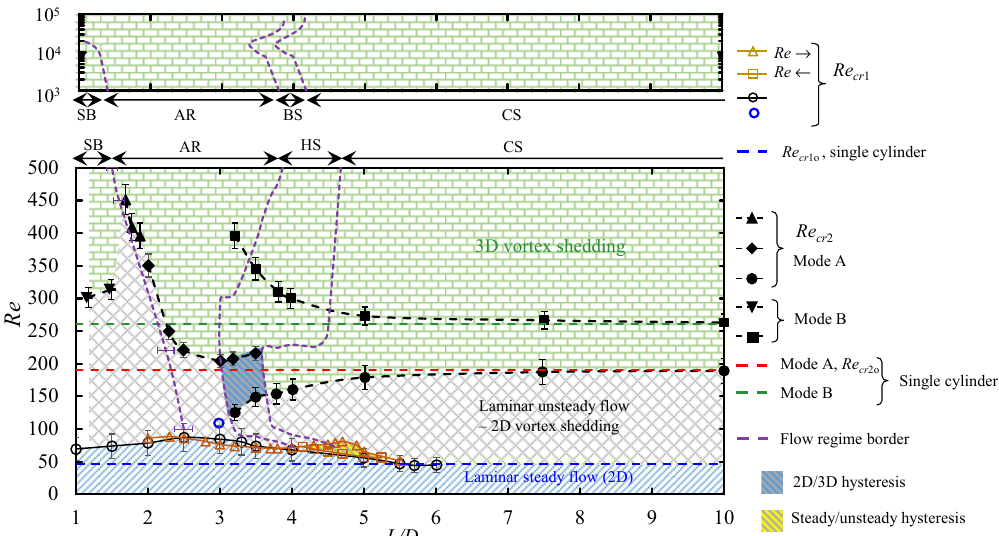
Figure 3. Marginal flow map (colored background) and flow regimes bordered by purple lines for two tandem circular cylinders . SB, slender/extended-body flow; AR, alternate reattachment flow; HS, hysteresis zone; BS, bi-stable flow; CS, co-shedding flow. Reproduced from Rastan and Alam [22]. For the definitions of the legends, please refer to Rastan and Alam [22]. Re cr 1 represents the flow transition from steady to two-dimensional unsteady while Re cr 2 indicates the flow transition from two-dimensional unsteady to three-dimensional unsteady.